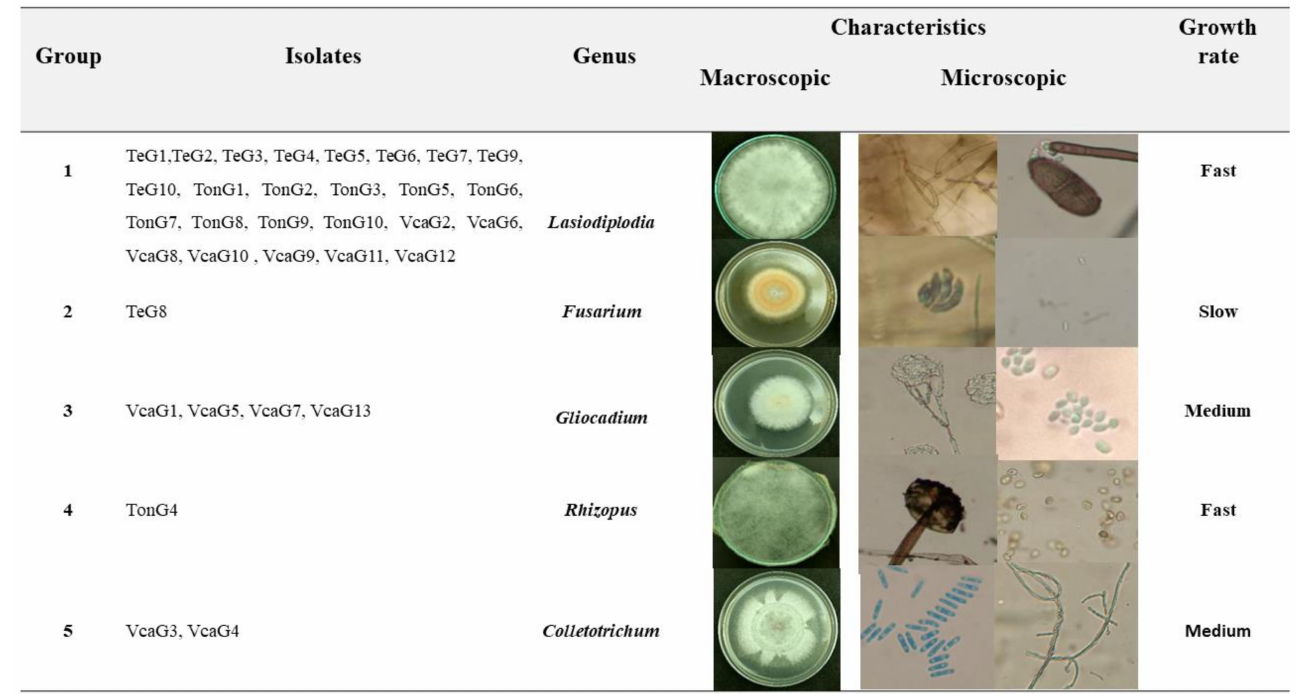
Figure 1. Classifications of pathogens isolated according to their morphological characteristics. The first group of colonies showed mycelium of rapid growth, white to grayish olive, spongy, and dense, of round cottony shape, with little elevation and filamentous at the edges. Over time, the colonies became black. Regarding microscopic morphology, hyphae were pigmented, thick-walled, and septated. The taxonomic keys and descriptions coincide with the genus Lasiodiplodia